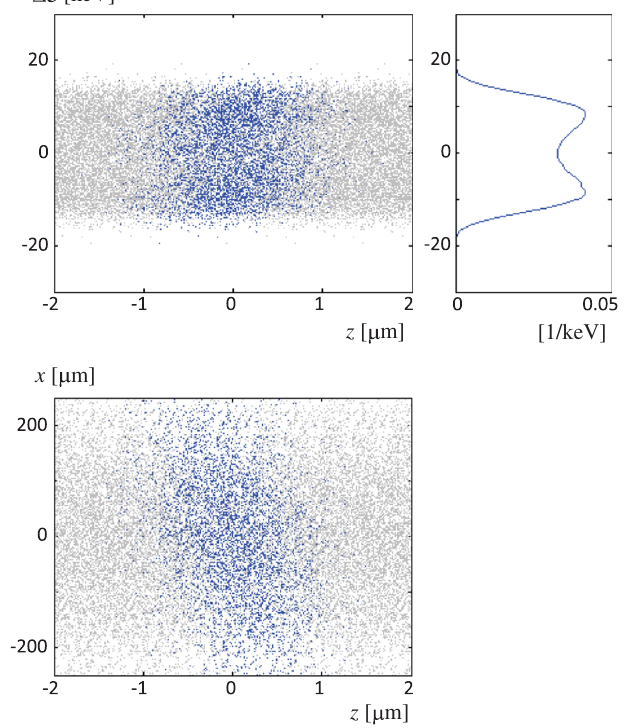
FIG. 18. Application C: beta functions and r 11 from the end of the laser heater undulator to an arbitrary lattice. The plot range is from the exit of the undulator to the beginning of the spectrometer magnet.